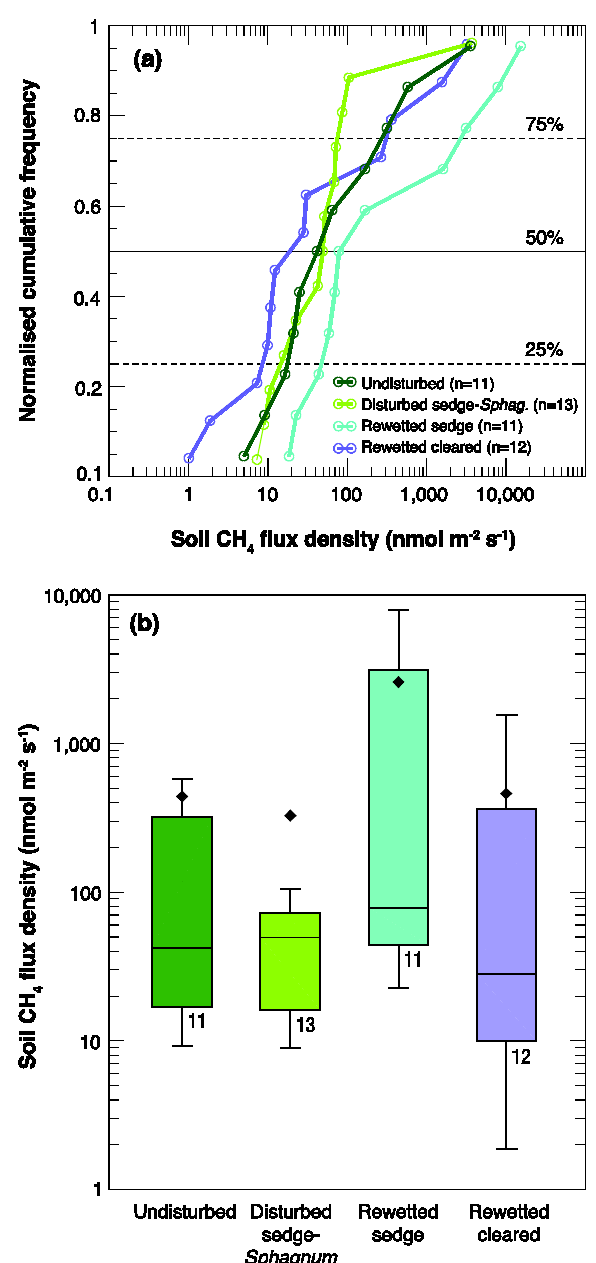
Figure 7. (a) Cumulative frequency distributions of individual soil methane (CH 4 ) flux measurements (all sites and all collars). Data from 17–18 and 24– 28 July, and 11 August 2014, are included. In order to visualise the large range of measured efflux values, the x -axis is shown on a logarithmic scale. Two points were negative and are not shown. (b) Distribution of soil CH 4 flux measurements (all valid runs from all collars, n = 47) for the same time intervals as in (a). In order to visualise the large range of measured efflux values, the y -axis is shown on a logarithmic